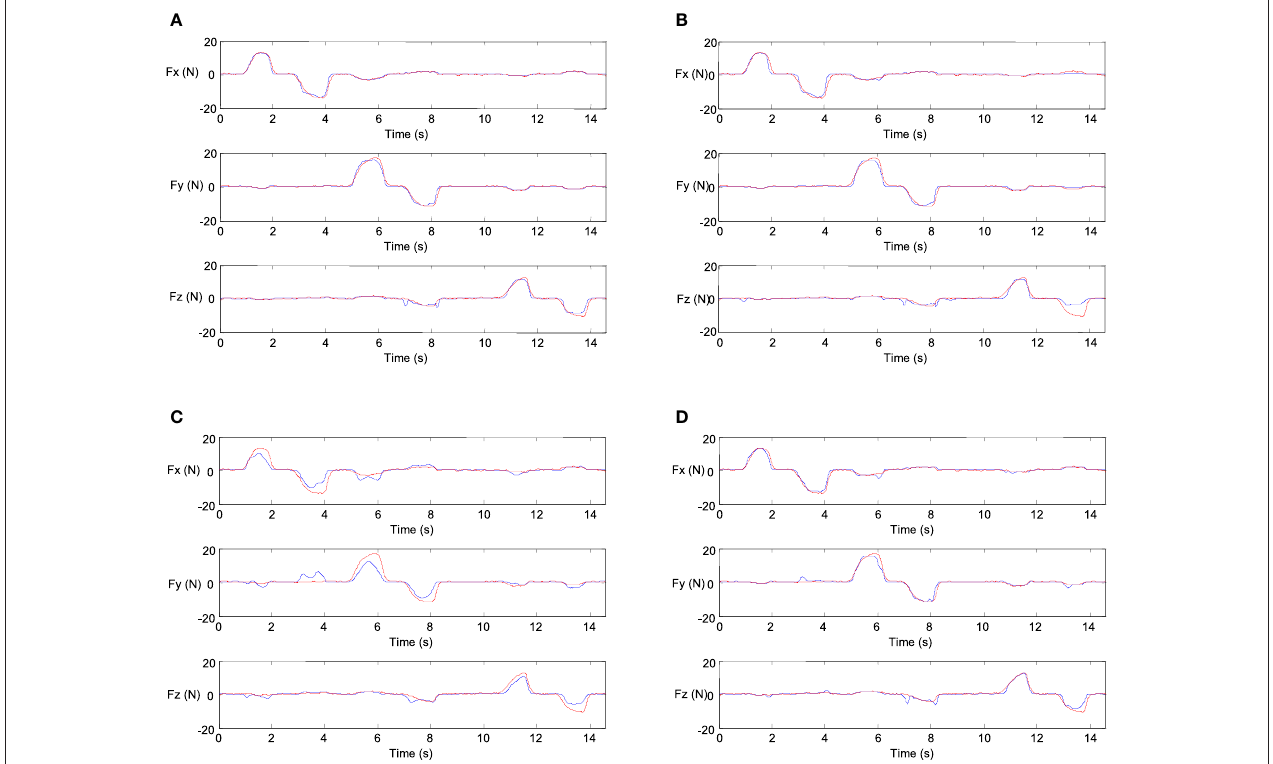
FIGURE 17 | The experimental results of the 3D force estimation. (A) Feature = WAV. (B) Feature = VAR. (C) Feature = ZC. (D) Feature = WA.